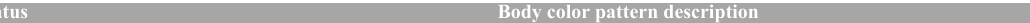
Table 3. Description of body color patterns observed in different social statuses. Territorial individuals have a bright background color, meanwhile non territorial presents dark background color. Also, reproductive individuals show a darkening of ventral body region, as opposed to the whitish ventral region in gregarious ones.